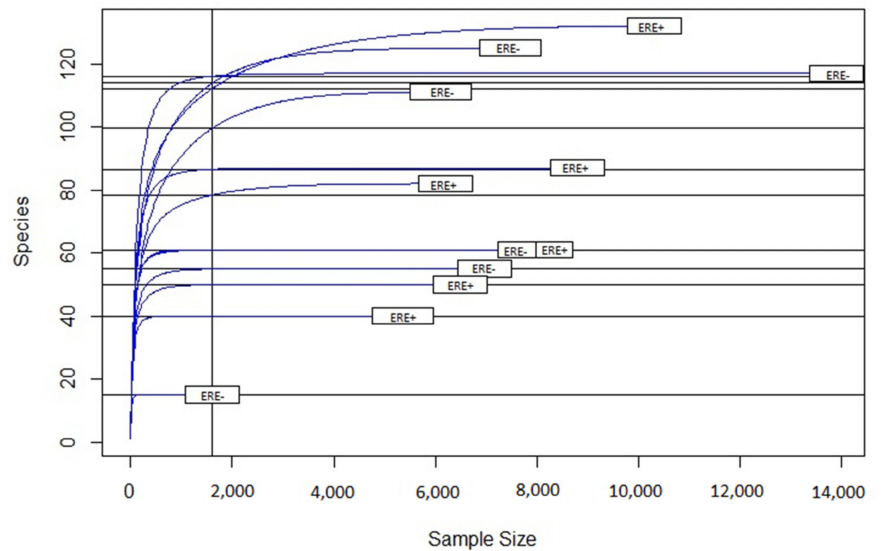
Figure 3. Rarefaction curve for sequence analysis. The vertical axis shows the number of di ff erent species (Operational taxonomic units, OTUs) that would be expected to be found after sampling the number of sequences shown on the horizontal axis. The curvature towards the horizontal indicates the greater sequencing e ff ort required to observe new species. The curve was obtained with the Rarefaction Species Richness script from the Vegan package on the Rstudio platform